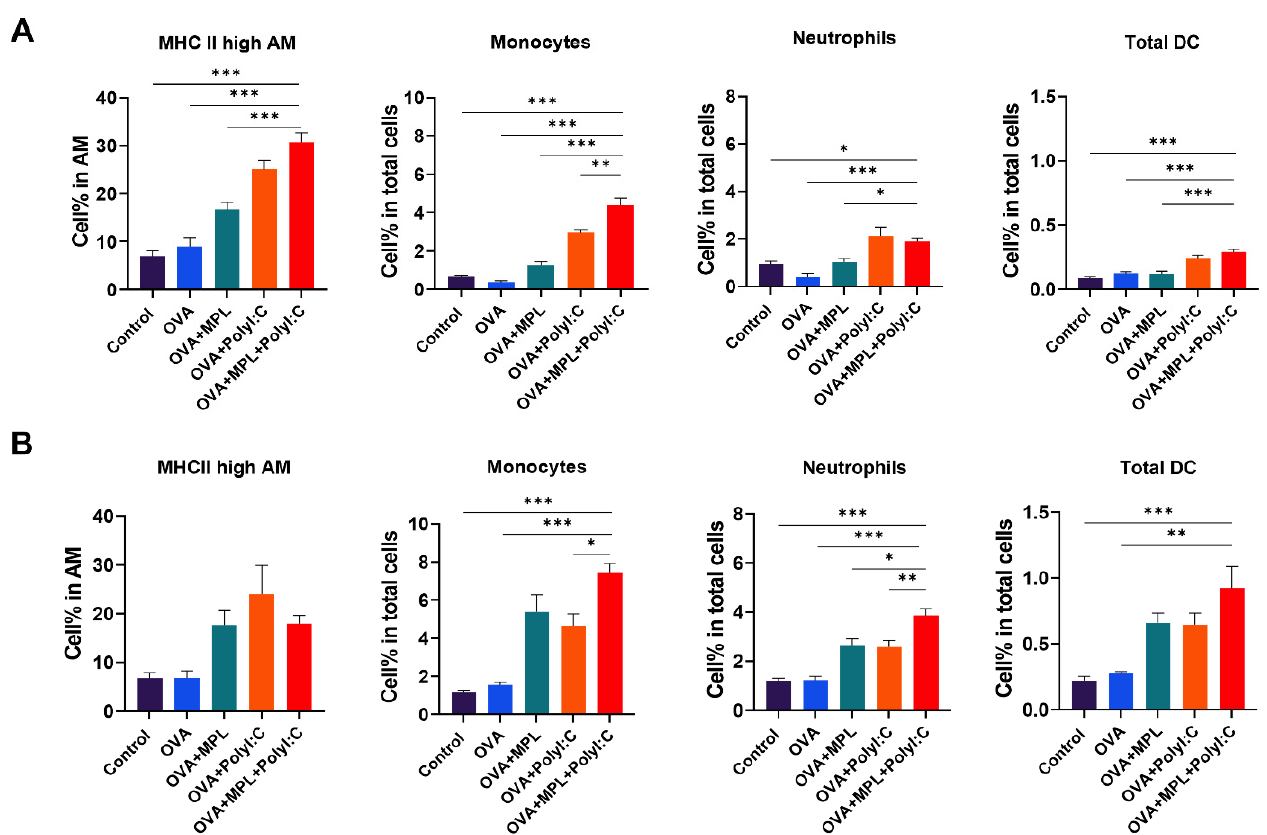
Figure 3. APC recruitment in Lungs after immunization. Lung cells were harvested from the mice one day after prime immunization ( A ) and boost immunization ( B ) . Cell phenotypes were analyzed by flow cytometry. All results were shown in mean ± SEM. For statistical analysis, One-way ANOVA and Tukey’s post-multiple comparison tests were performed. * p < 0.05; ** p < 0.01; and *** p < 0.001 between the indicated groups.